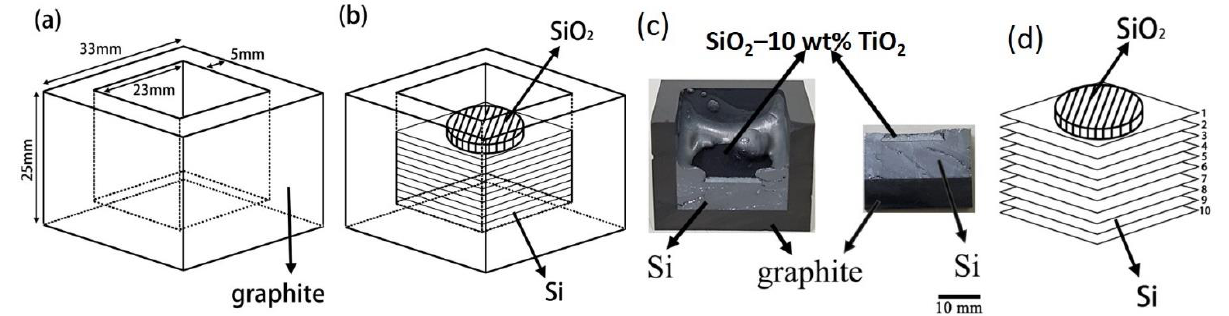
Figure 1. Photograph of green bodies and sintered (1300 °C for 2 h) samples of SiO 2 and SiO 2 with ceramic additives.